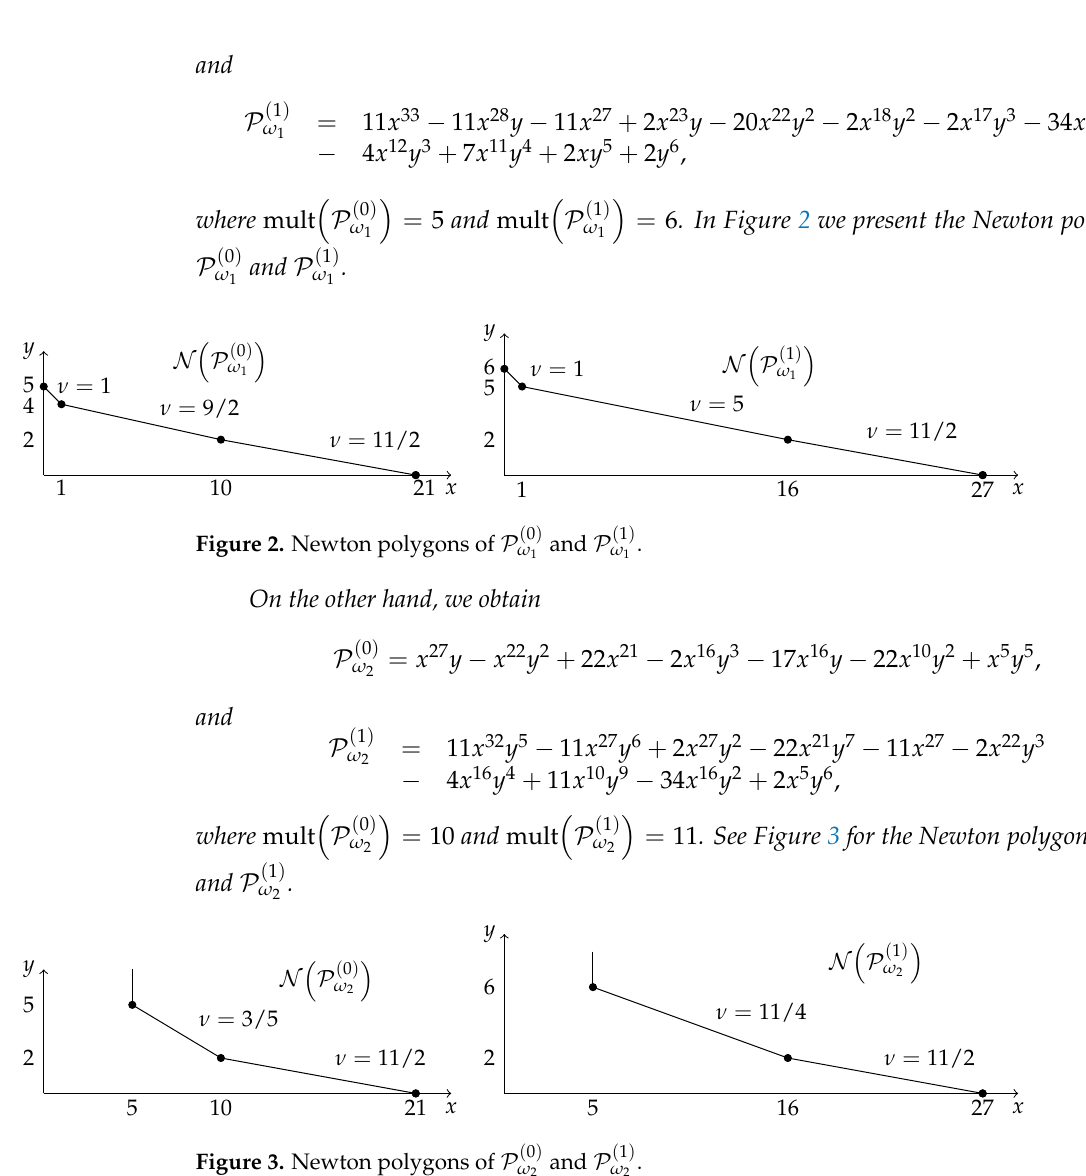
( 0 ) P ( 1 ) ω 2 and ω 2